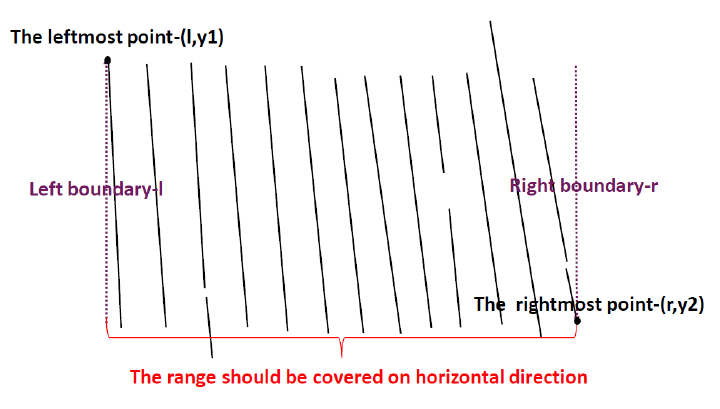
Figure 9. Outermost frame